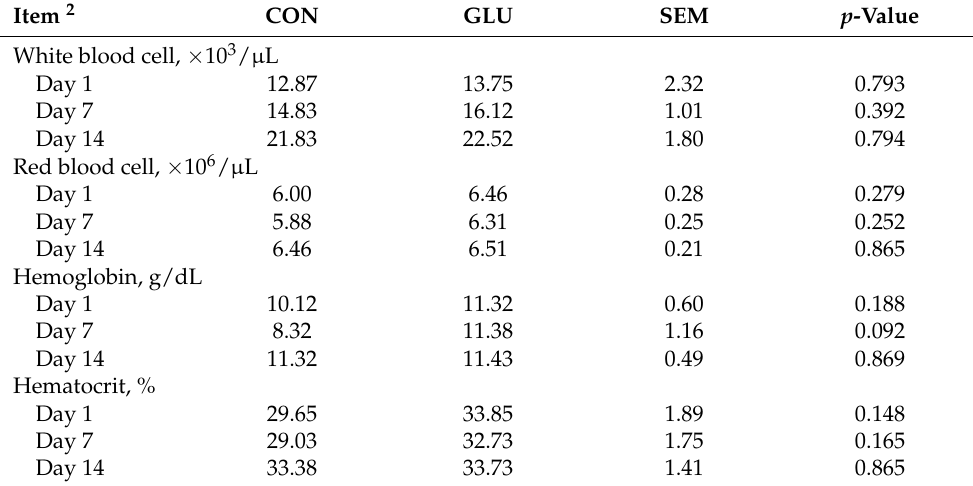
Table 6. Effects of dietary treatments on blood profiles of weaned pigs 1 .